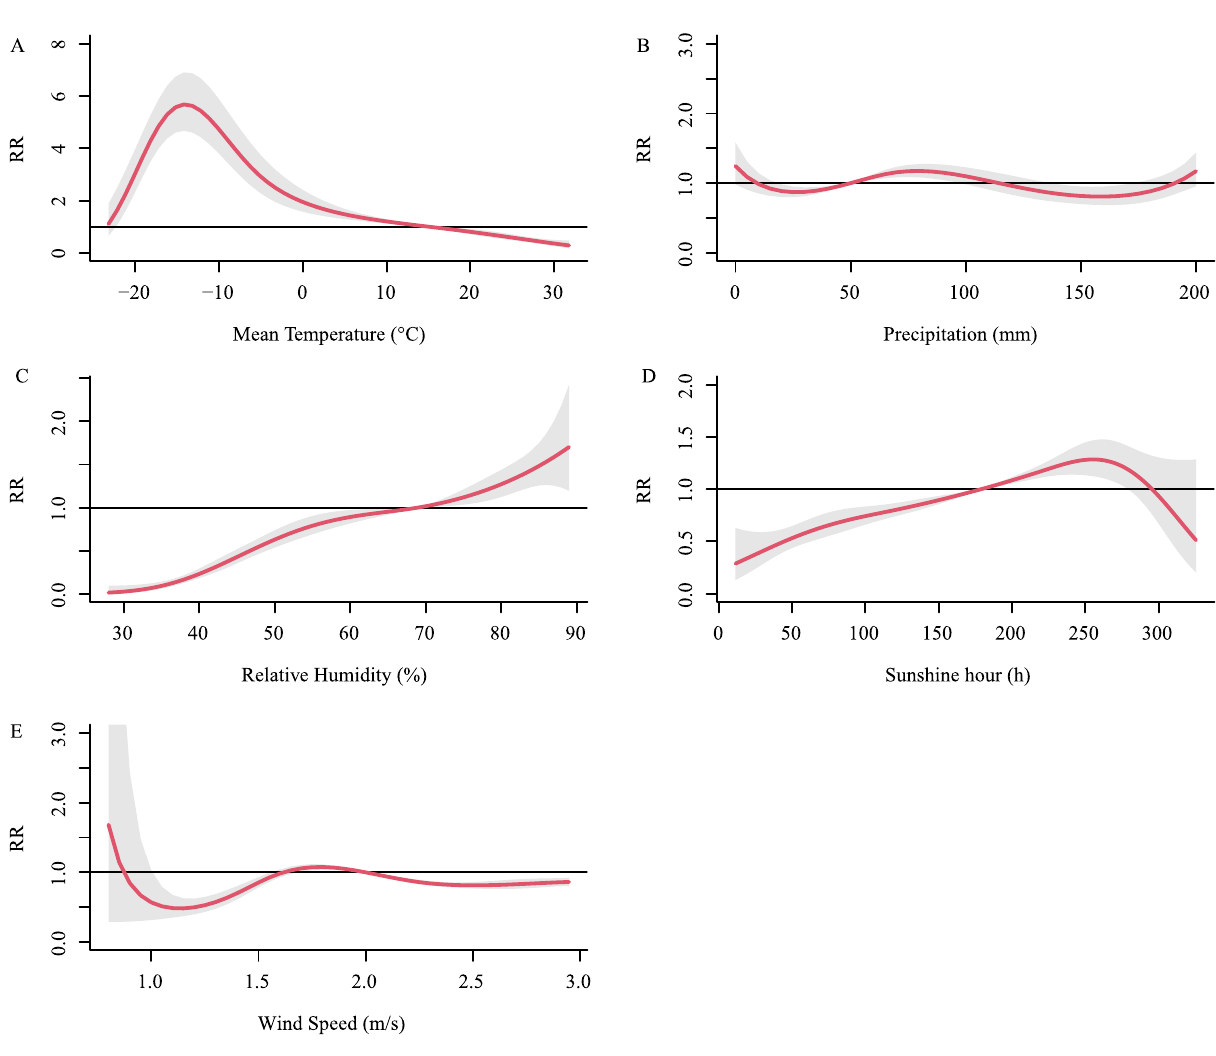
Figure 7. Summary of cumulative exposure–response curves for HFRS incidence with a lag of 0–6 months for meteorological factors from 2004 to 2018 in the multivariate model. The Y-axis represents the relative risk of each variable. The x-axis represents the range of observations for each variable. Red lines represent means estimated using the DLNM model, shaded areas represent 95% confidence